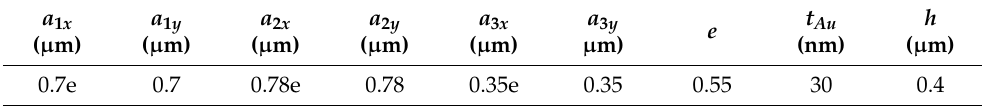
Table 4. Optimal geometrical parameters of the proposed SPR-PCF.